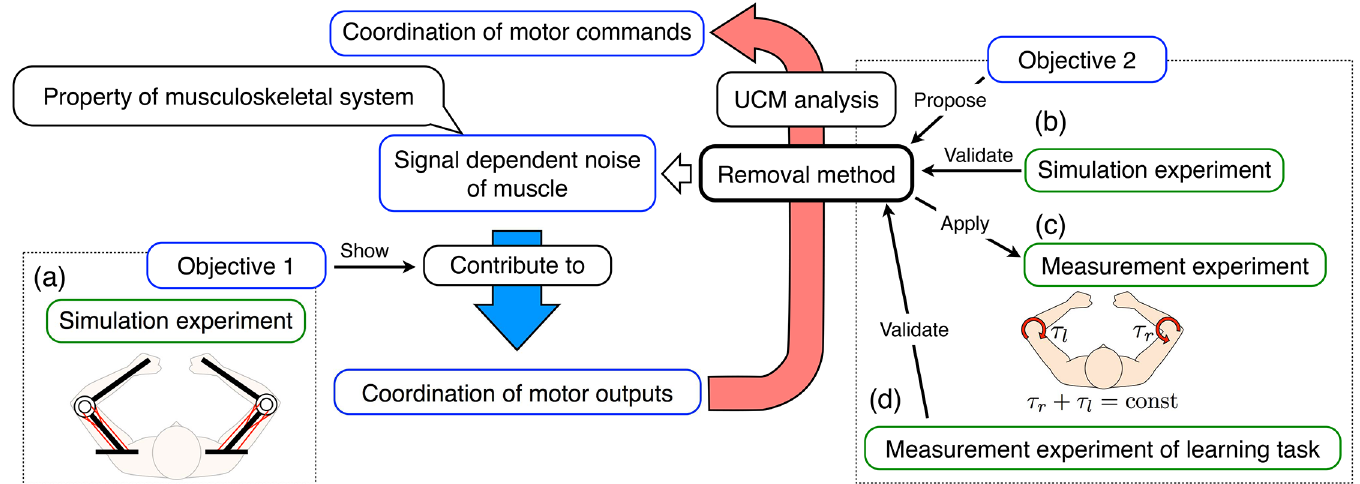
Fig 1. Concept of coordination of motor commands. (a) The simulation experiment shows that signal-dependent noise in the muscle contributes to the coordination of motor outputs. We propose a method that removes the effects of the musculoskeletal system for the assessment of the coordination of motor commands. (b) The simulation experiment validates our proposed method. (c) To show the coordination of motor commands of human subjects, the proposed method is applied to the measurement experiment in which the subjects perform the same task as the simulation experiment. (d) To empirically validate the proposed method, it is applied to the measurement experiment of the learning